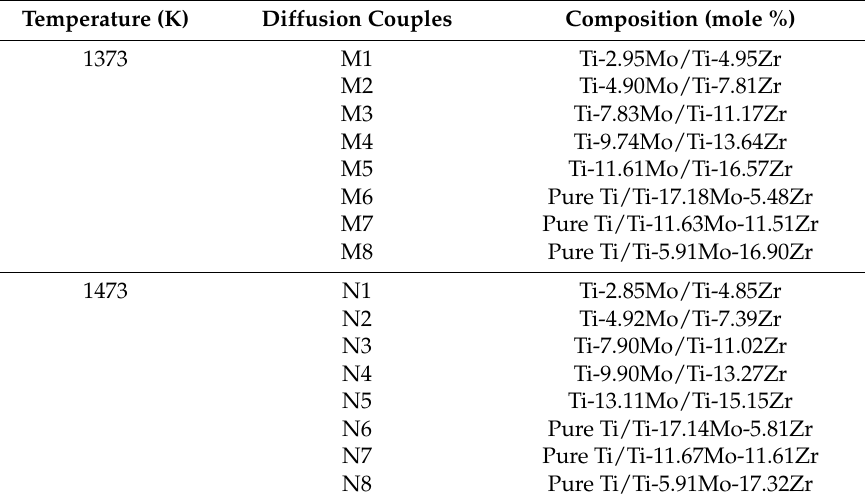
Figure 1. Phase diagram of ( a ) Ti-Mo [40] , ( b ) Ti-Zr [41] , ( c ) Zr-Mo [42] , and ( d ) Ti-Mo-Zr [43] systems. Table 1. Compositions of diffusion couples.